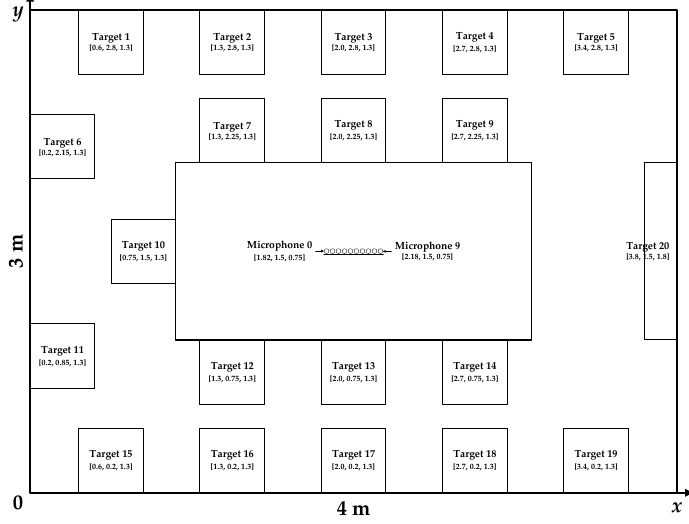
Figure 3. The meeting room acoustic environment with 20 target speech sources and a uniform linear microphone array.